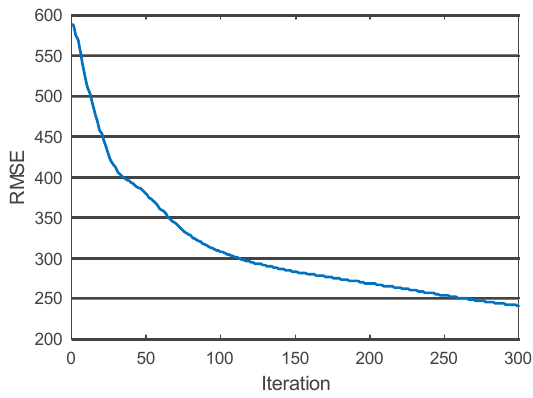
Figure 13. Training progress of the CNN.